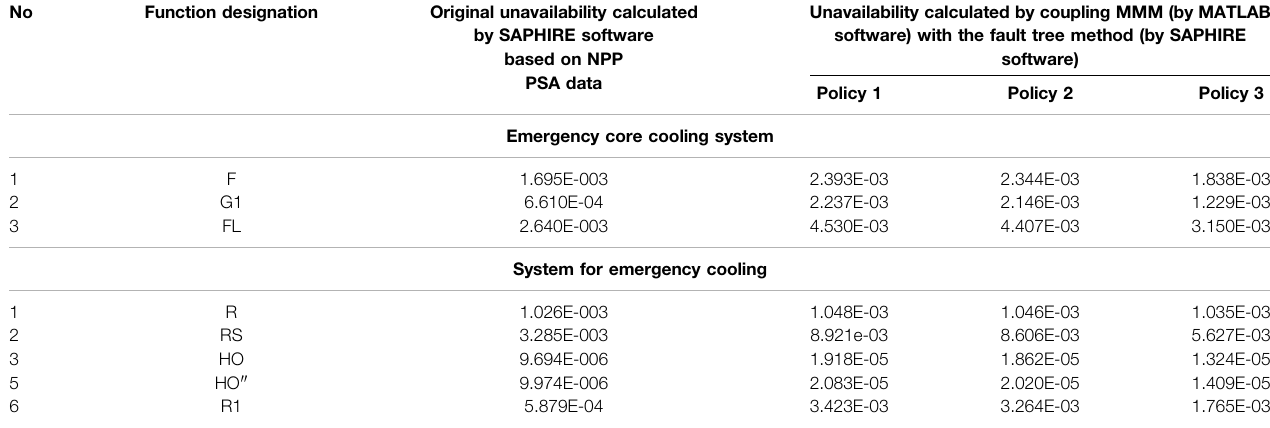
TABLE 6 | Comparison of original unavailability (calculated by FT using NPP PSA data) and unavailability calculated through a coupling process.